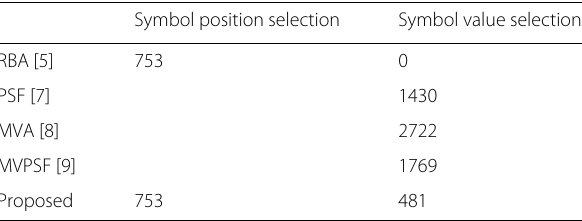
Table 3 Number of real operations for the symbol flipping algorithm for 63 × 37, GF(16) LDPC code